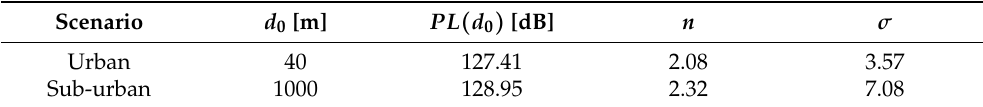
Table 3. Parameters of the propagation model [19].